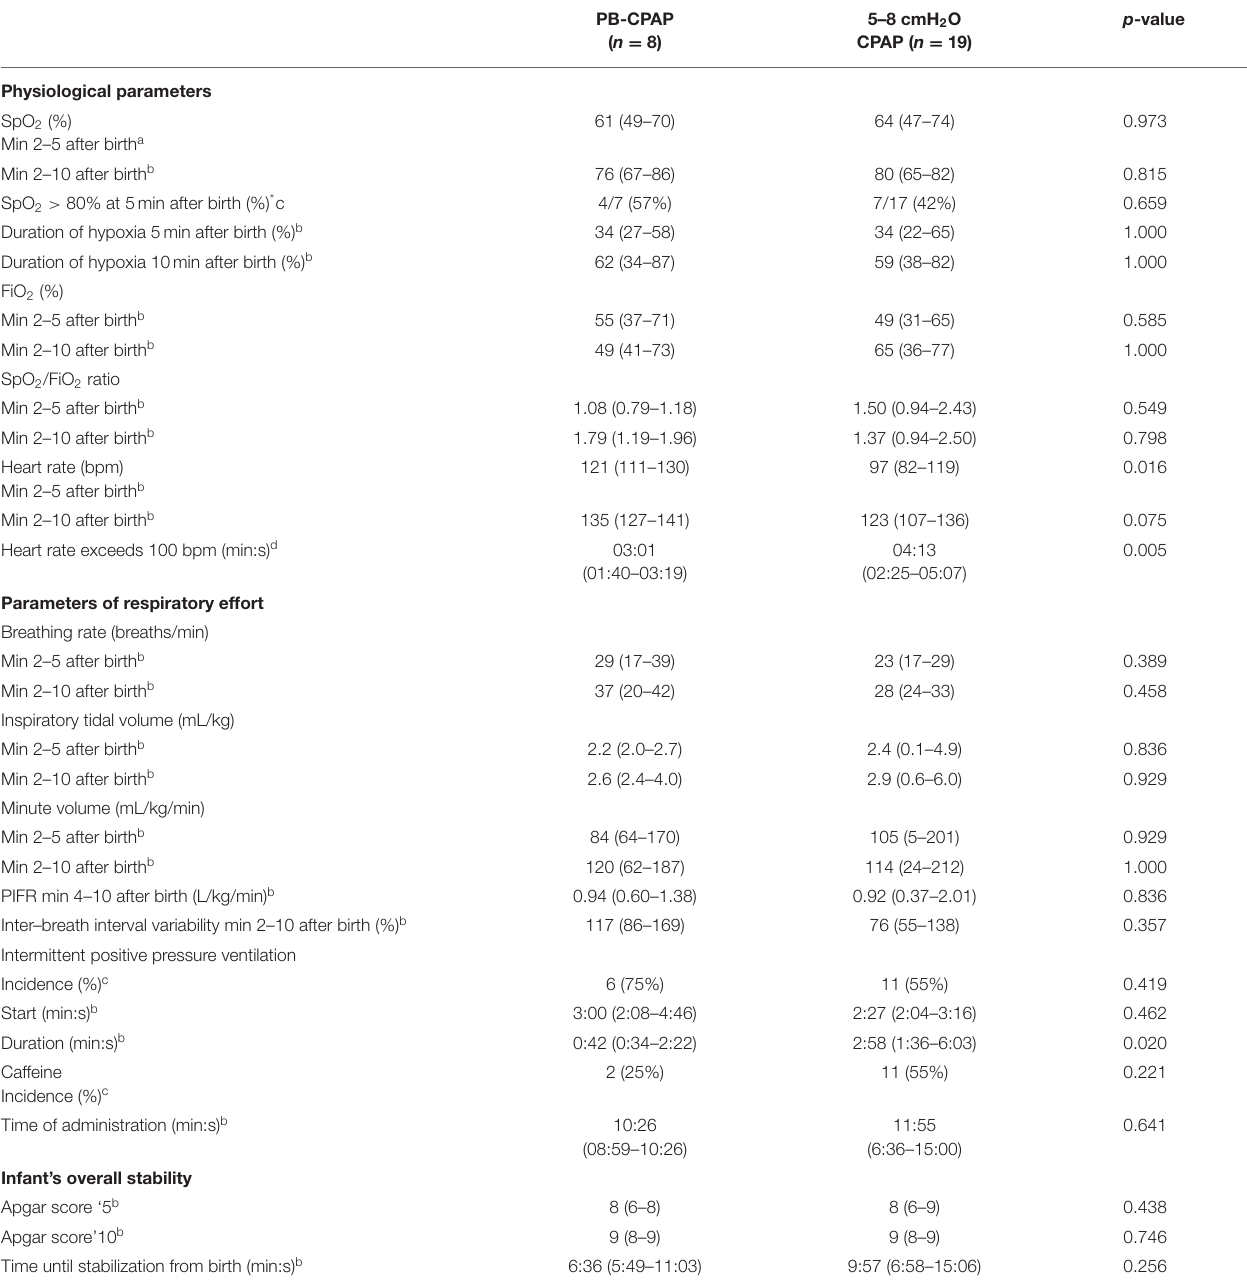
TABLE 2 | Parameters of physiology and respiratory effort in the delivery